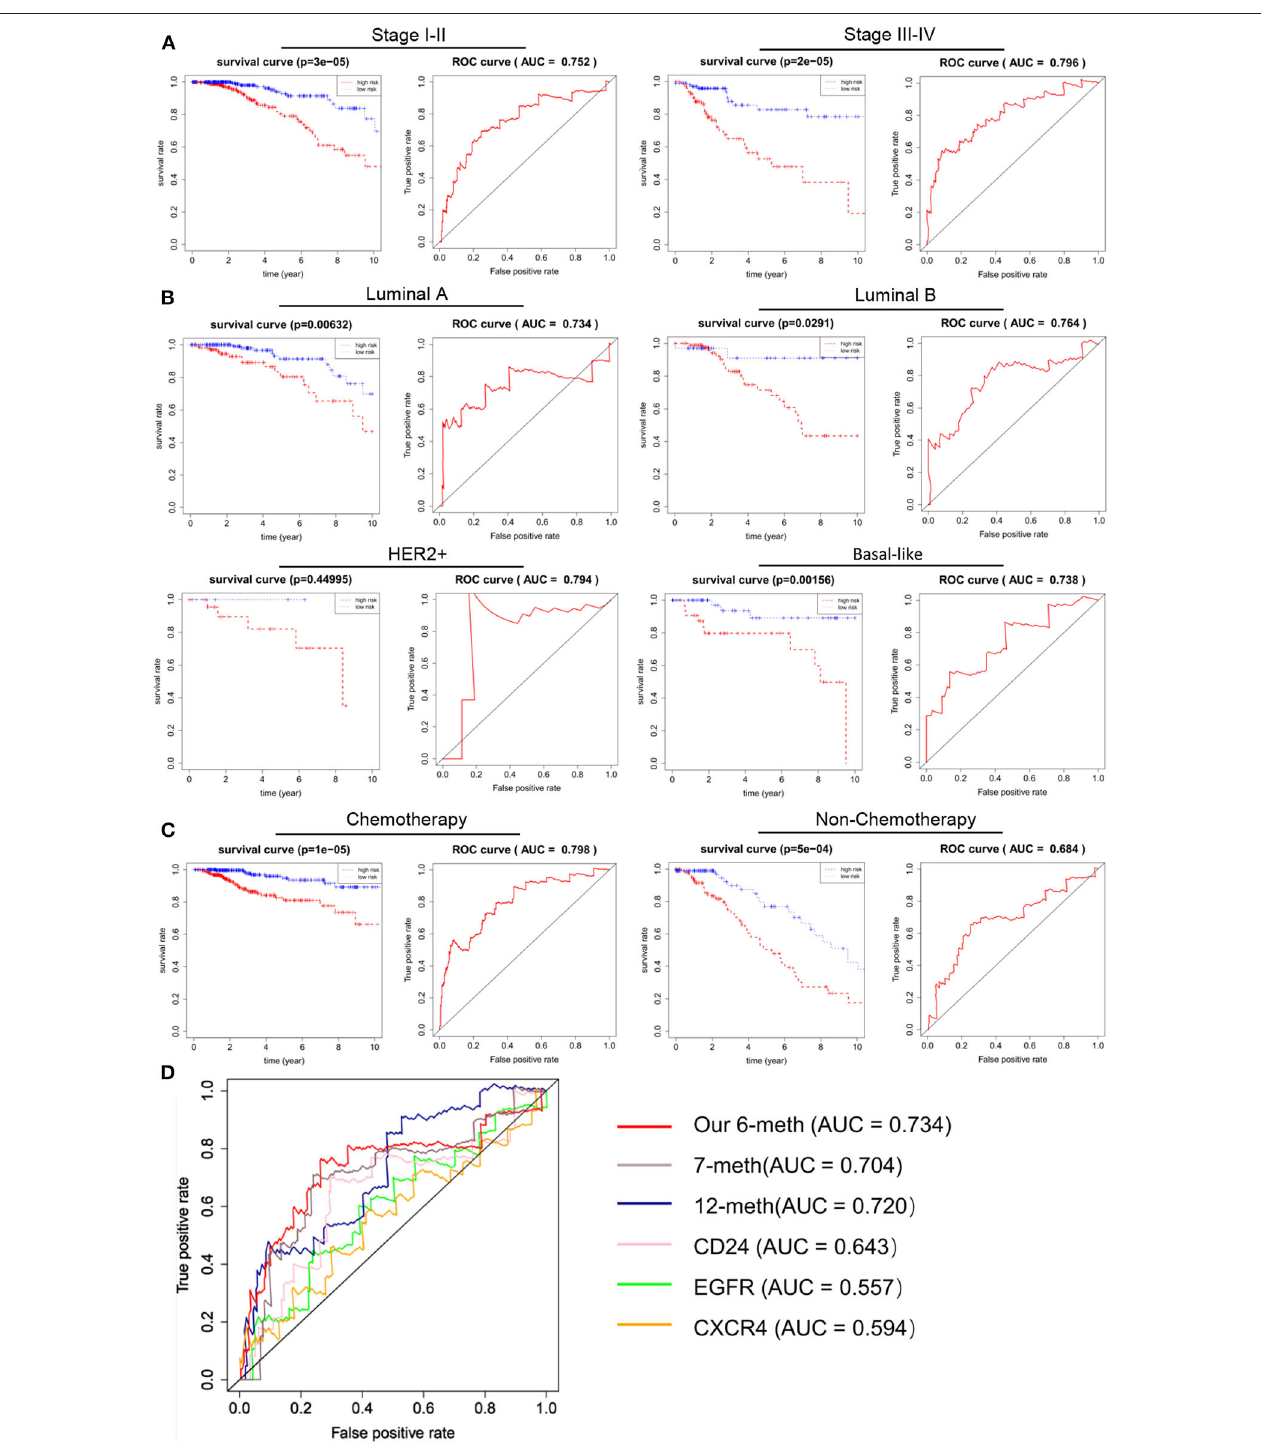
FIGURE 6 | Independence of 6 DNA methylation markers in OS prediction, and comparison with reported markers. A Kaplan–Meier and ROC analysis were performed on patients with different stages of BRCA. Stage I-II ( N = 560, 72.16%), Stage III-IV ( N = 205, 26.42%). (B) Kaplan–Meier and ROC analyses were performed on BRCA patients with different phenotypes. According to their tumor phenotype, luminal A breast cancer ( N = 277, 35.70%), luminal B breast cancer ( N = 126, 16.24%), HER2 + breast cancer ( N = 29, 3.74%) and basal-like breast cancer ( N = 85, 10.95%). (C) Kaplan–Meier and ROC analysis were performed on BRCA patients with different treatment regimens. Grouped according to whether they were undergoing chemotherapy. After chemotherapy ( N = 583, 75.13%), no chemotherapy ( N = 193, 24.87%). (D) The ROC curve shows the sensitivity and specificity of our 6 DNA methylation markers and other known biomarkers in predicting patient OS based on the TCGA validation data